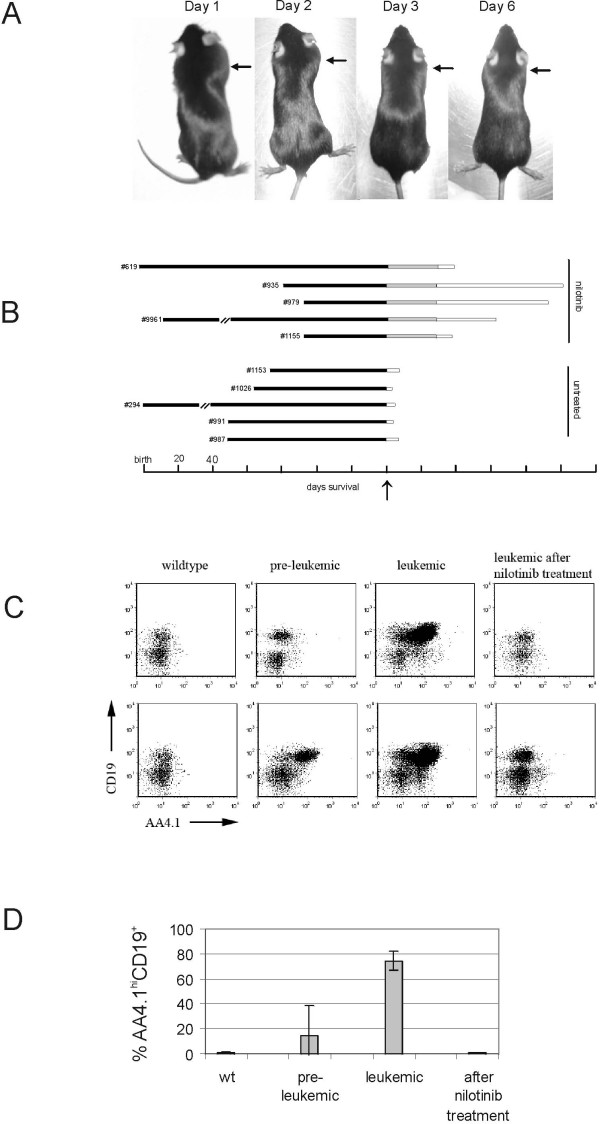
Analysis of nilotinib in a transgenic mouse model of terminal leukemia/lymphoma. (A), Five P190 Bcr/Abl transgenic mice were treated with 75 mg/kg nilotinib daily upon visible signs of lymphoma for a period of 30 days. This image shows one of the five mice treated with the drug. Arrows point to the dramatic reduction in the size of the lymph node swelling/lymphoma over a period of six days of treatment. (B), Survival after diagnosis of overt leukemia/lymphoma. Numbers to the left indicate individual identifiers of the transgenic mice. The arrow points to the first diagnosis of leukemia/lymphoma. The black line represents time to leukemia (days), the grey bars the period of treatment with nilotinib and the white bars time to death after no treatment. (C), Peripheral blood of two wild type (Wt) littermates; two overtly leukemic P190 Bcr/Abl transgenic mice before treatment and the same mice after 7 days of 75 mg/kg nilotinib treatment. Dead cells were excluded based on propidium iodide uptake and the analysis was restricted to living mononuclear cells by forward and side scatter gate settings. Antibodies are as indicated. (D), Percentage of peripheral blood cells that had cell surface expression of CD19 and high levels of AA4.1. Bars, ± SEM. Wild type, n = 3; preleukemic, n = 3; leukemic, n = 3; nilotinib-treated, n = 2.